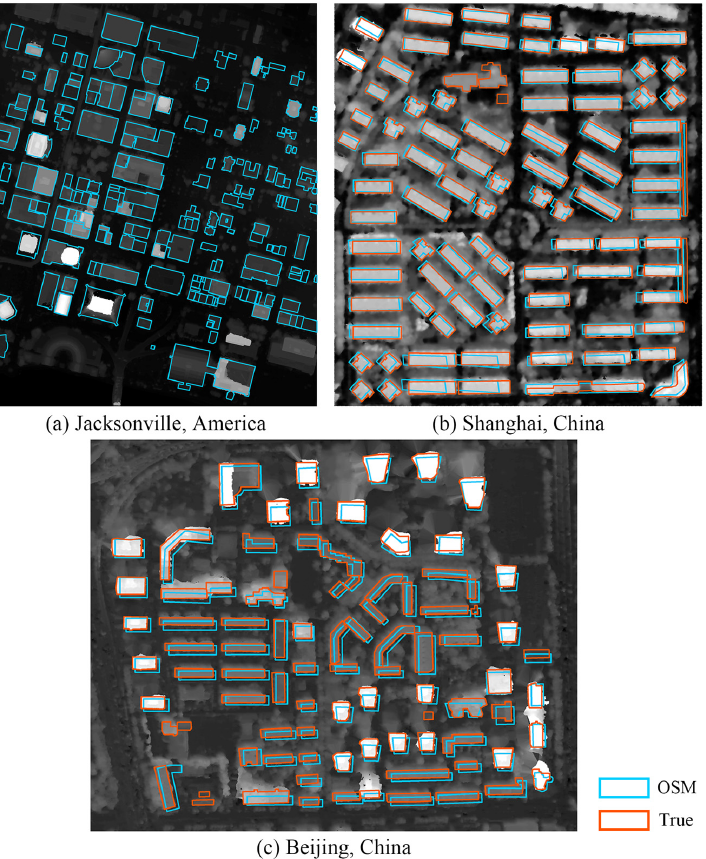
Figure 8. The DSM, OSM, and true building polygons of the three experimental regions.